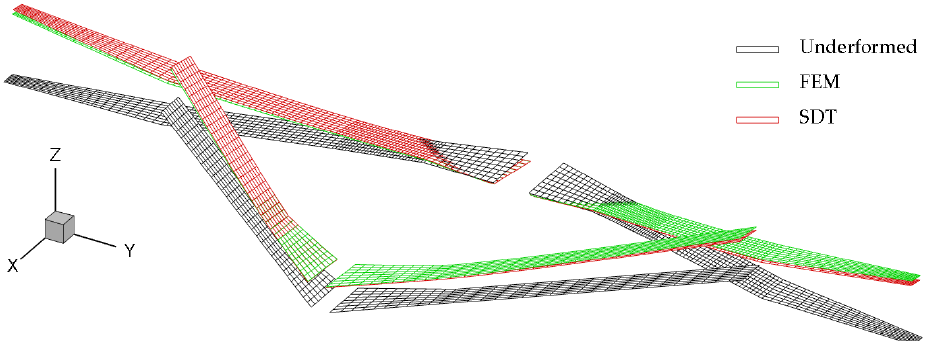
Figure 11. Interpolated lifting surfaces for evaluation of overall deformation.